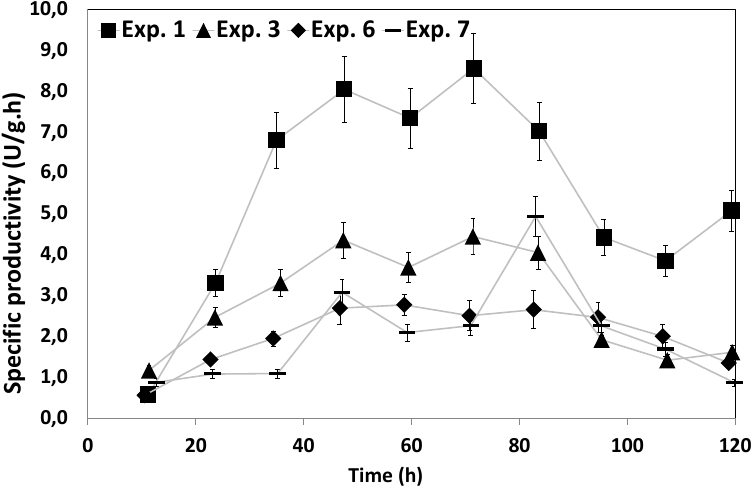
Figure 5. Coefficient plot for the model which correlates dissolved oxygen (DO) and residence time (t) as quantitative factors to the specific